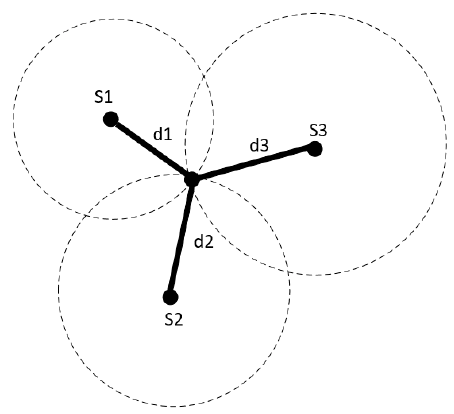
Figure 2. Lateration method